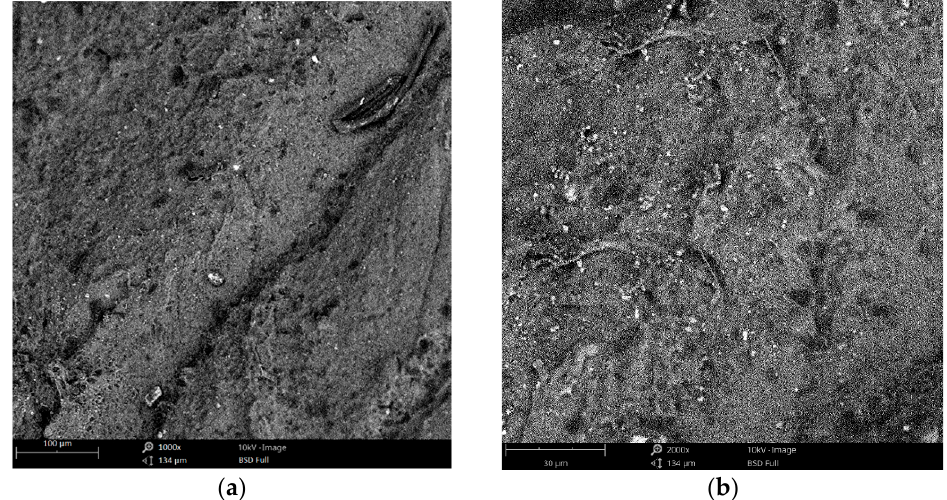
Figure 3. SEM images of the MWCNTs/SDS/PDMS composites at magnifications of ( a ) 1000× and ( b ) 2000×. The white and black colours represent the presence of surfactants and MWCNTs, respec- tively.